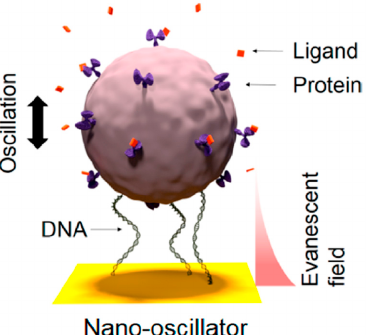
Figure 9. Schematic representation of particle oscillation anchored on a gold substrate by alternating voltage. The particle was tethered by DNA duplexes. When AC voltage was applied, the particle was oscillated according to the surface charge of the particle. The distance from the substrate was measured using a plasmon imaging technique. Reproduced from Ref. [96] with permission. Copyright 2019 American Chemical Society.